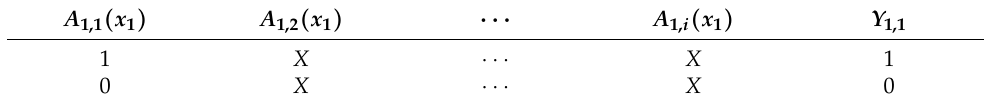
Table 16. Partial coding for a compact system with architecture II.